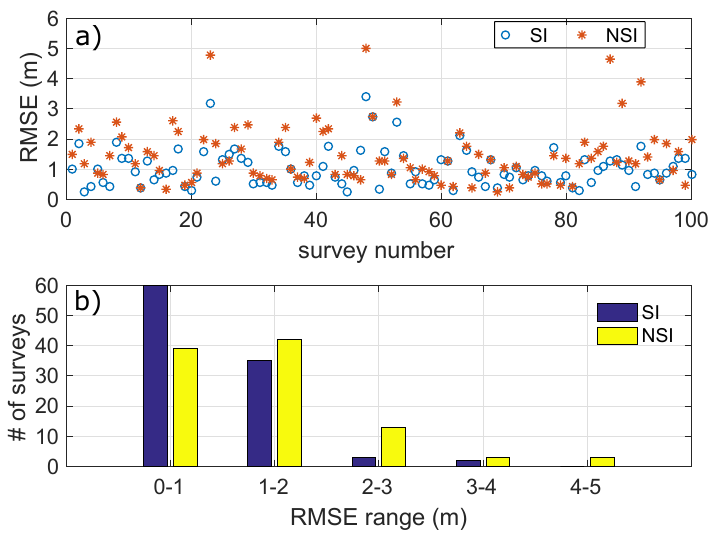
Figure 7. Root Mean Squared Error for each surveyed day of shorelines derived from stabilized and non-stabilized images ( a ), and number of shoreline sorted according to RMSE ranges ( b